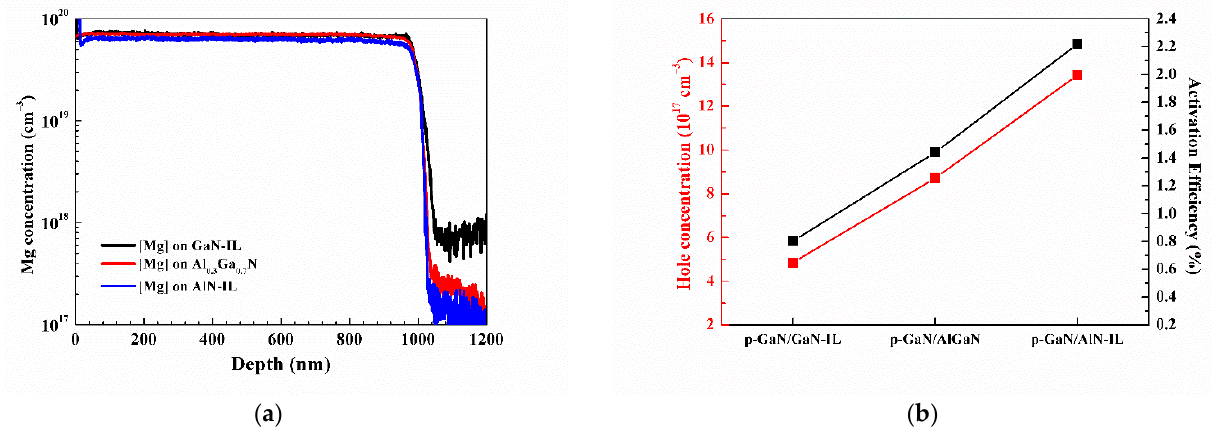
Figure 4. ( a ) Mg concentration profile measured by SIMS for three different structures. ( b ) The hole concentration (red squares) and activation efficiency (black squares) of Mg-doped p-GaN layers grown on GaN-IL, AlGaN, and AlN-IL un- der-layers.